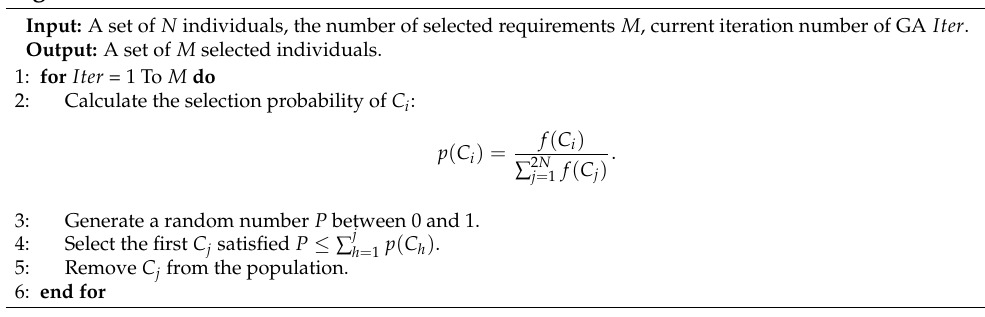
Algorithm 1 Roulette wheel selection.